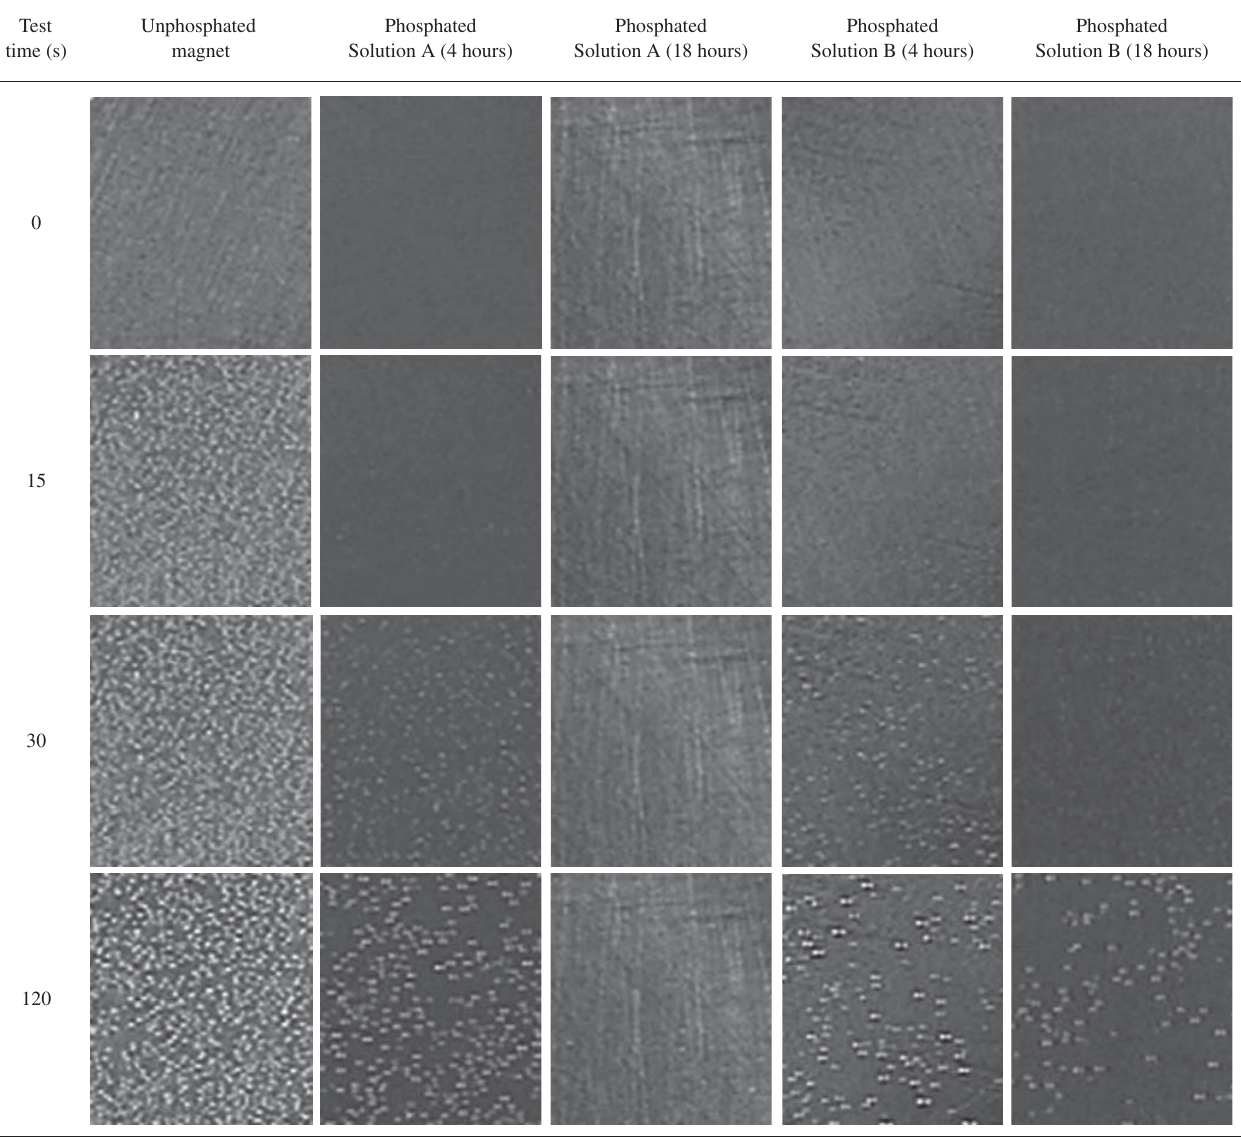
bubble release from the magnet surfaces, is easily seen. 2